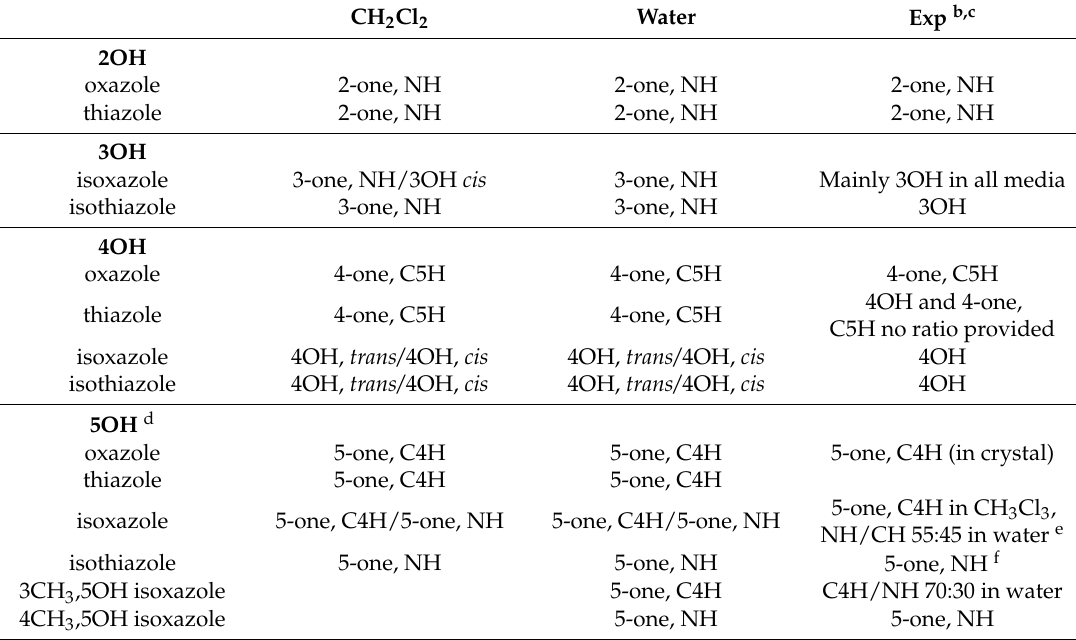
Table 3. The prevailing tautomers for the OH derivatives in solution with relative free energy of at least 4.184 kJ/mol a